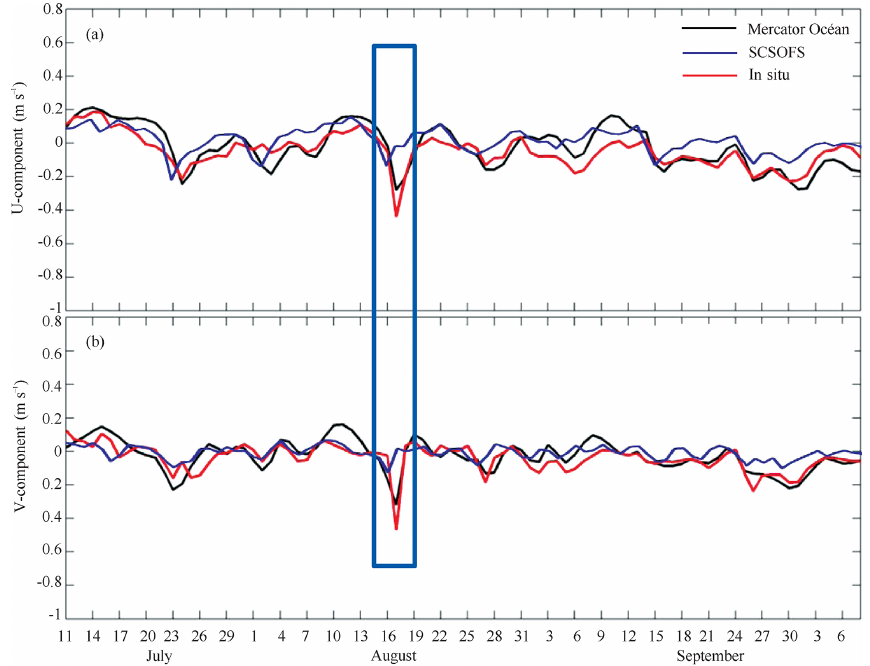
Figure 3. The daily mean time series of u (a) and v (b) components in 40m depth layer at the Maoming mooring station, from in situ observations, Mercator Océan, and SCSOFS